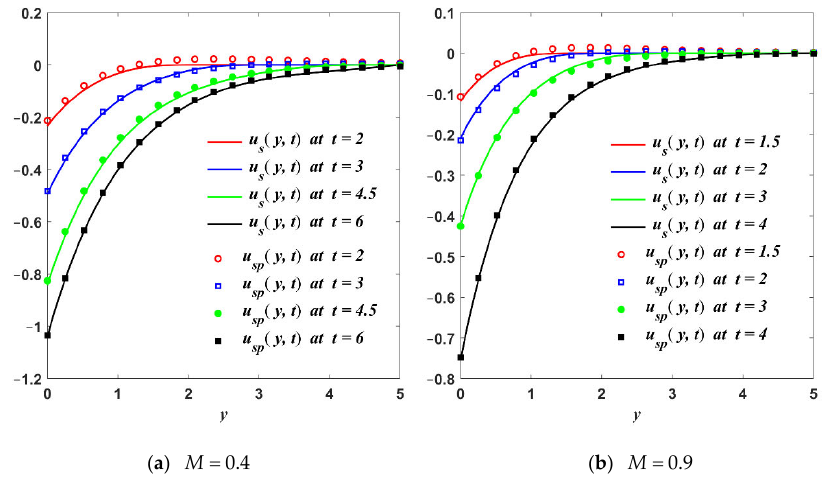
Figure 6. Convergence of starting velocity u s ( y , t ) (numerical solution) to its steady-state component u sp ( y , t ) for α = 0.8, β = 0.7, γ = 0.6, ω = π /12, K = 0.4, and two values of M .